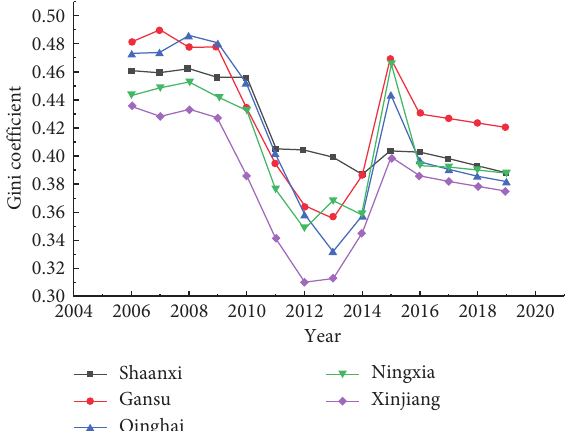
Figure 6: The Gini coefficients and prediction values of Northwest China.